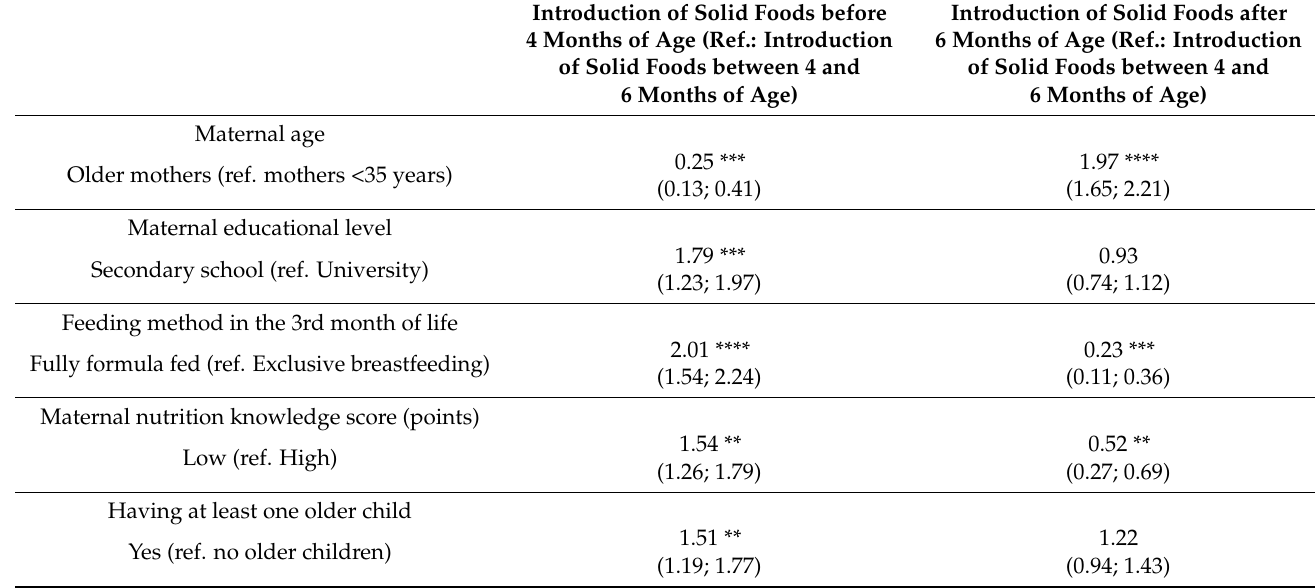
Table 2. Odds ratios (95% confidence interval). The associations between maternal factors, feeding method in the 3rd month of life and age at which solid foods were